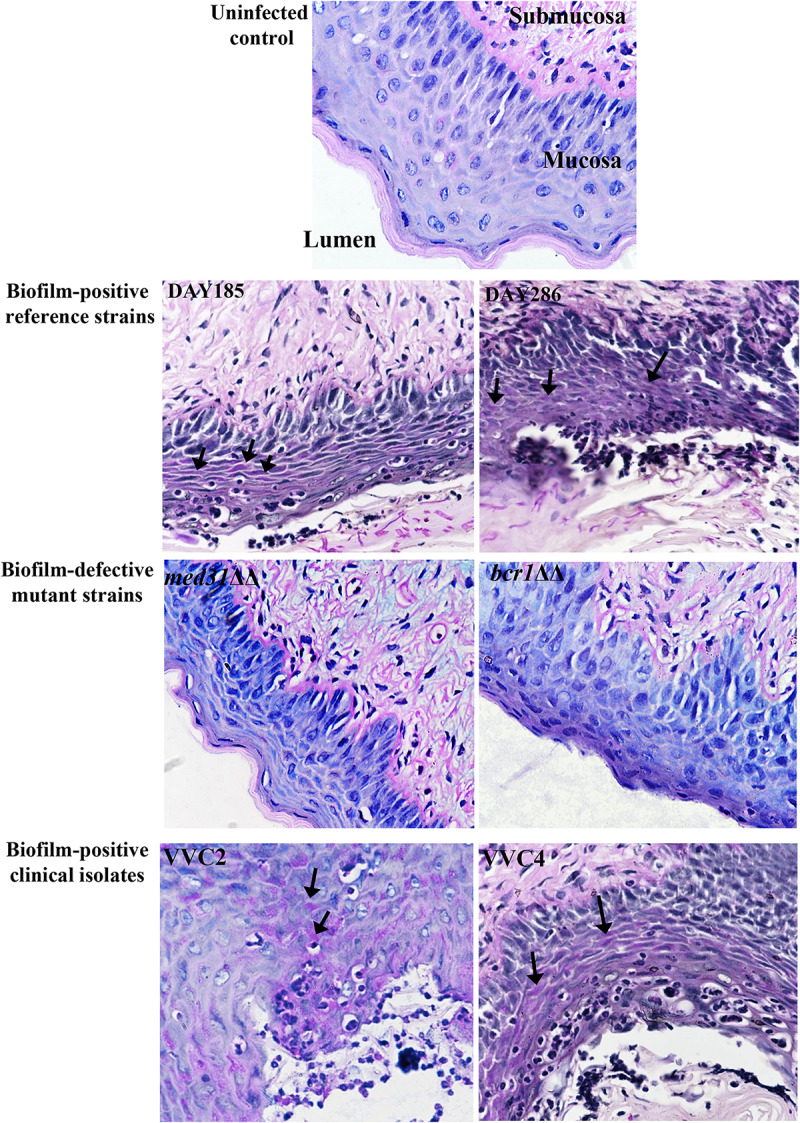
Histology of the vagina of mice infected by C. albicans shows fungal infiltration within the vaginal epithelium. Vaginal histopathological examination (PAS staining, 400×) showed that C. albicans penetrated the cornified epithelium and formed fungal infiltrations in the mucosal layer. The lumen, mucosa, and submucosa in the uninfected control are denoted for orientation. Evident endocytosed hyphae or fungal infiltrations (black arrows) in the mucosa were observed when C. albicans biofilm-positive reference strains (DAY185 and DAY286) and clinical isolates (VVC2 and VVC4), but not biofilm-negative mutants (med31ΔΔ and bcr1ΔΔ), were used to infect mice. The experiments were repeated on three different occasions.